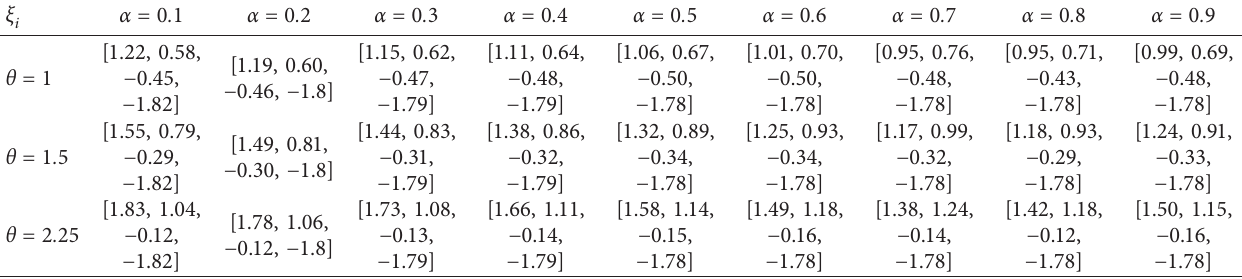
Table 7: The overall dominance values of risk levels with different values of α and θ in case of q � 3.